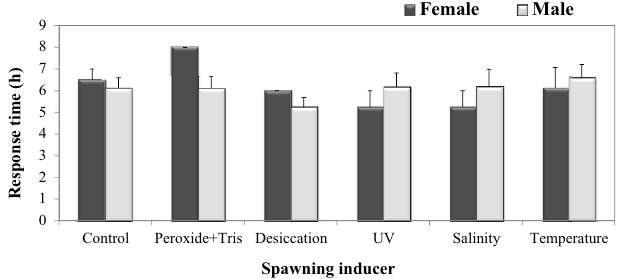
Fig. 3. Cittarium pica . Response time (h) to spawning stimulation. Values are